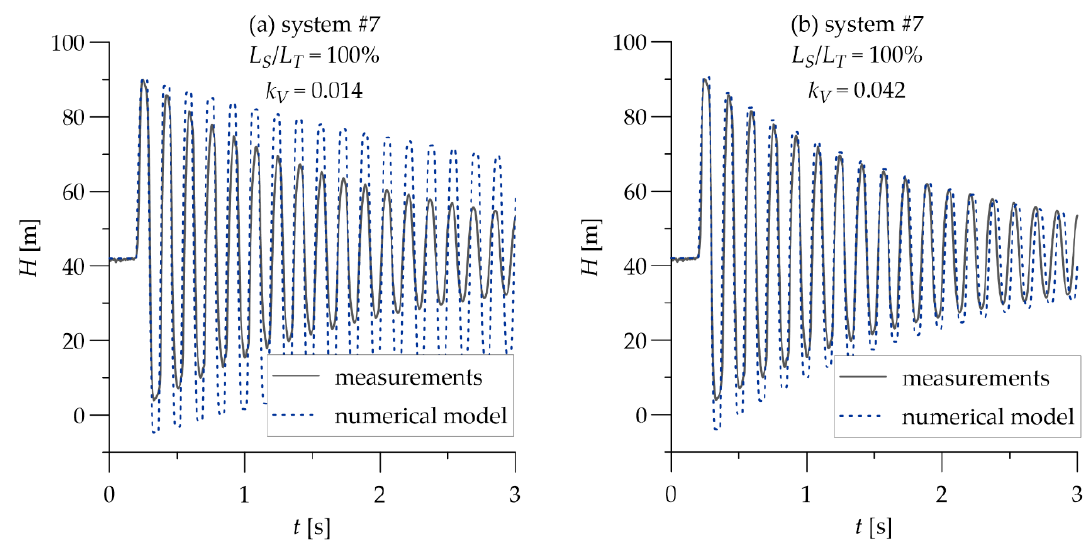
Figure 9. Comparison between calculated and measured pressure oscillations: ( a ) Unsteady friction coefficient calculated using Equations (5) and (7); and ( b ) Calibrated unsteady friction coefficient.